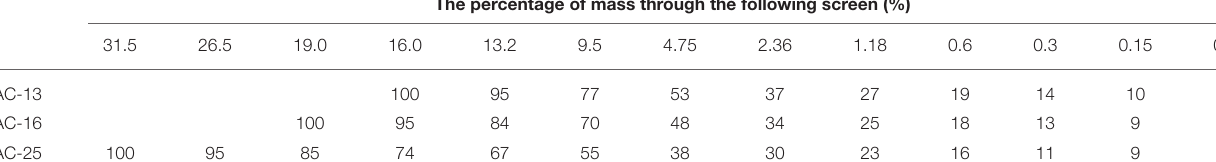
TABLE 2 | The gradation composition of asphalt mixture. The percentage of mass through the following screen (%)